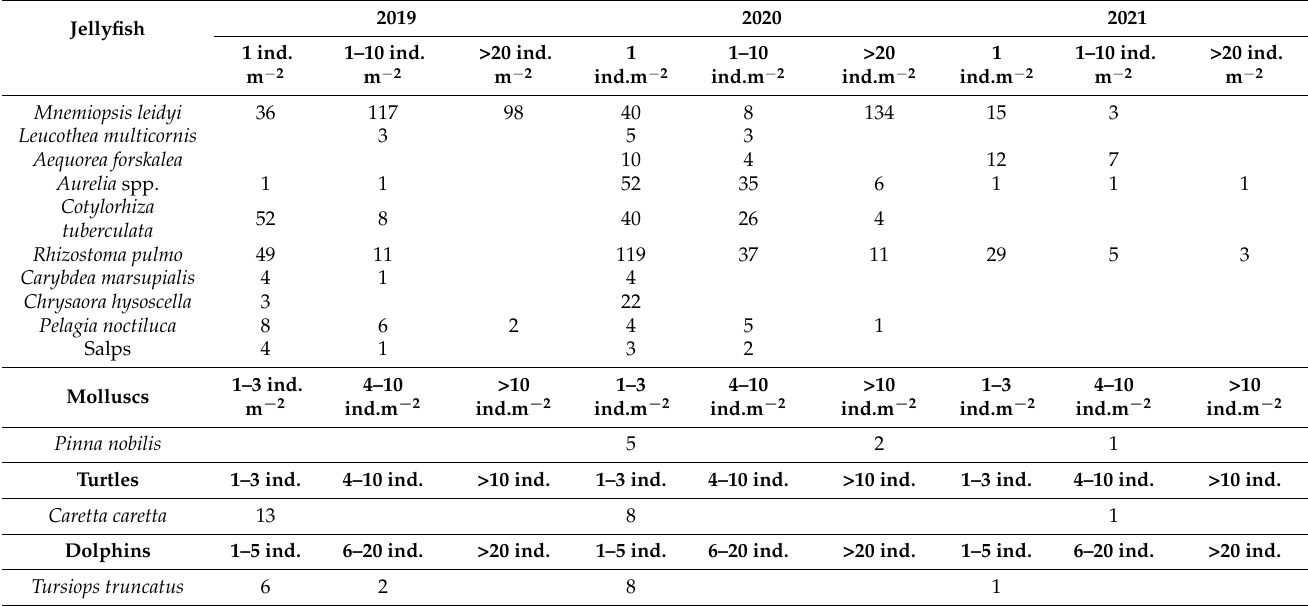
Table 2. Number of sightings collected for each signaled taxon. Sightings are separated per year and per reported abundance